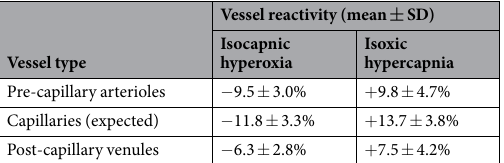
to − 14% 8, 9, 29–32 . Here, we show that a comparable definite constriction ranging from − 6% to − 10% can be measured in vessels with baseline diameter < 25 µ m (Table 3). Isoxic hypercapnic challenge that raises PaCO 2